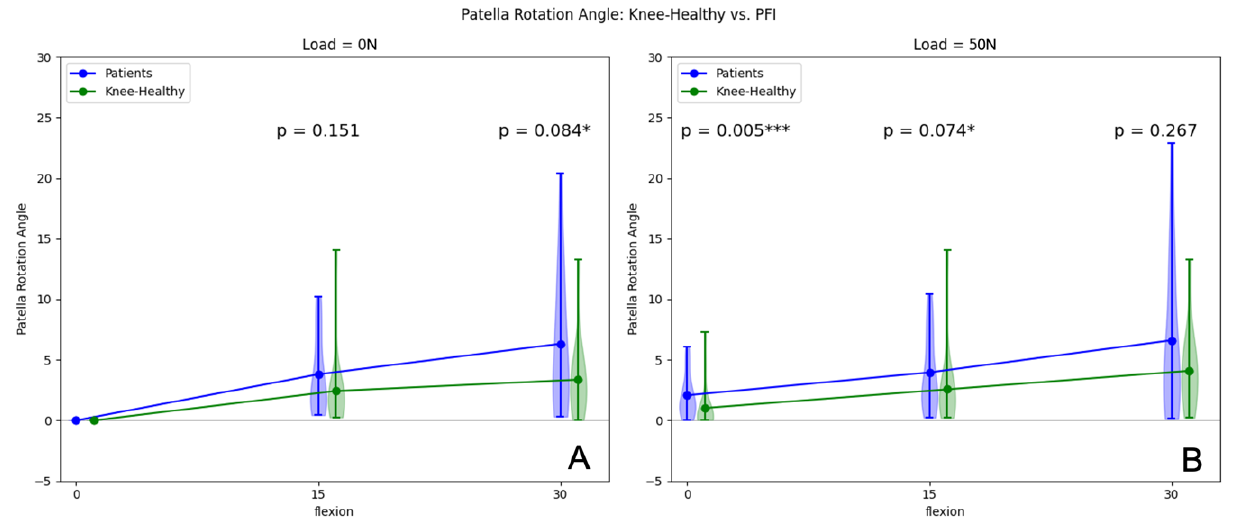
Figure 6. Patellar rotation (degree) in unloaded ( A ) and loaded (50 N) situations ( B ) of patients and volunteers from 0° to 30° flexion . * p -values < 0.01, *** p -values < 0.01.